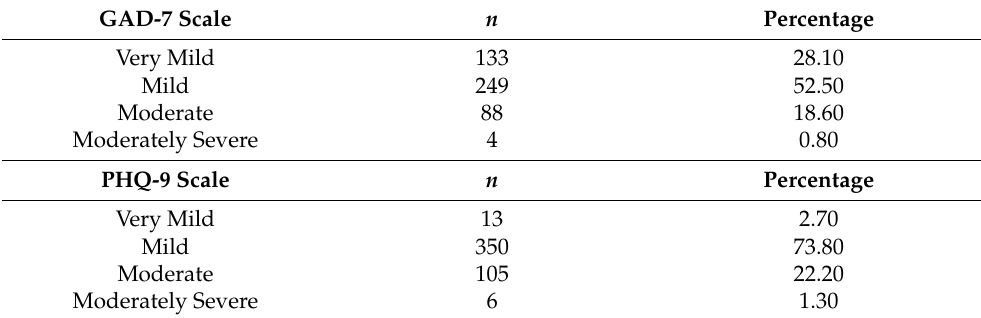
Table 3. Self-reported anxiety and depression levels of social media users in